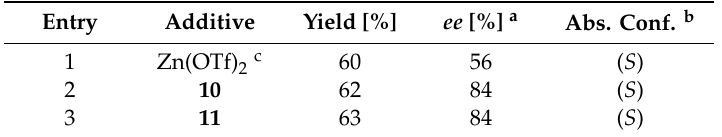
Table 2. Asymmetric Friedel–Crafts reaction catalyzed by aziridine-phosphine 6 .